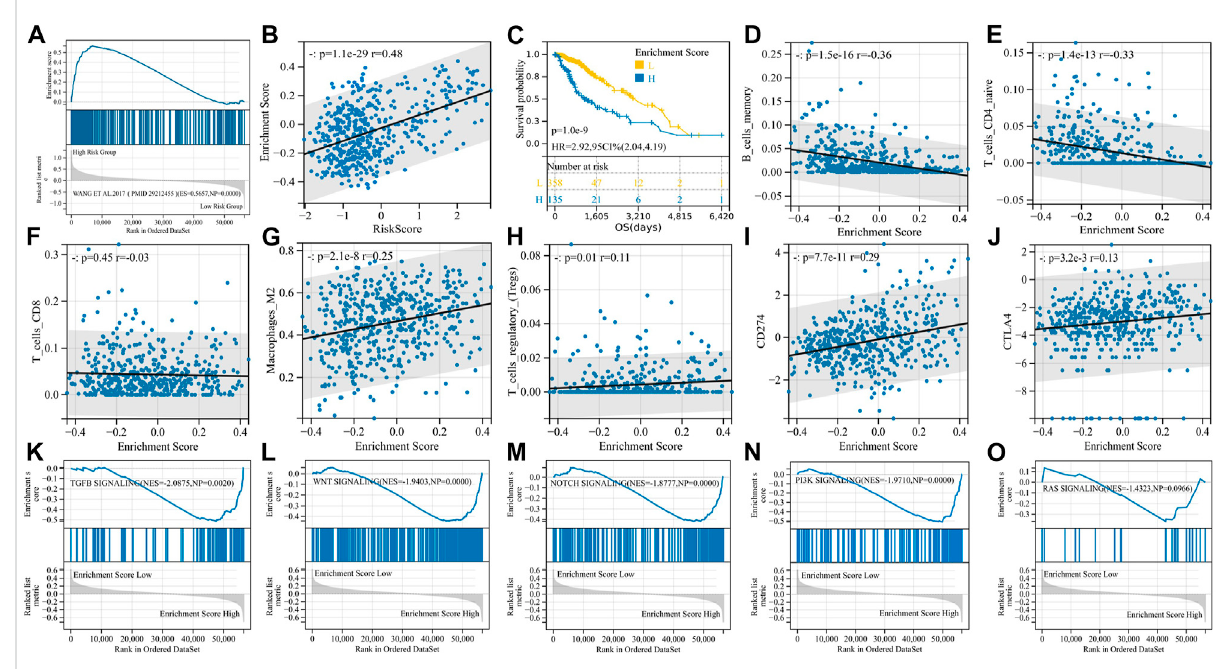
FIGURE 5 EMT phenotypes are signi fi cantly associated with M2 macrophages and are regulated by the TGF- β signaling pathway. (A) GSEA enrichment curveforthePMID29212455:Wang_et_al.2017geneset; (B) enrichmentscoreandriskscorearesigni fi cantlypositivelycorrelated; (C) K-Mcurvefor the enrichment score; (D – J) correlation analysis of enrichment scores and immunity; and (K – O) GSEA enrichment curve for EMT-related signaling